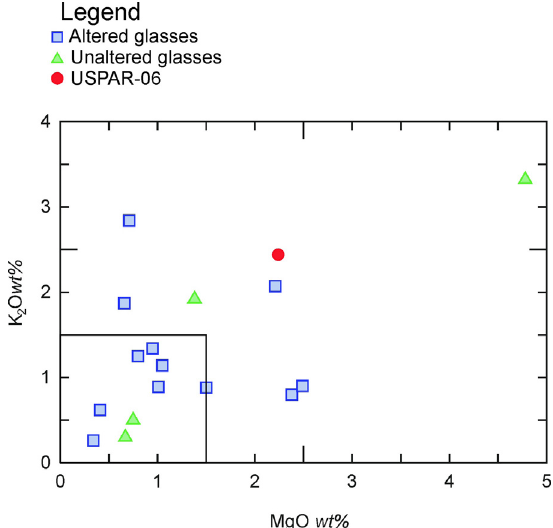
O binary plot highlights the fragments of glass whose values are above 1.5 wt% and that were produced Figure 7: MgO vs K 2 with a plant ash